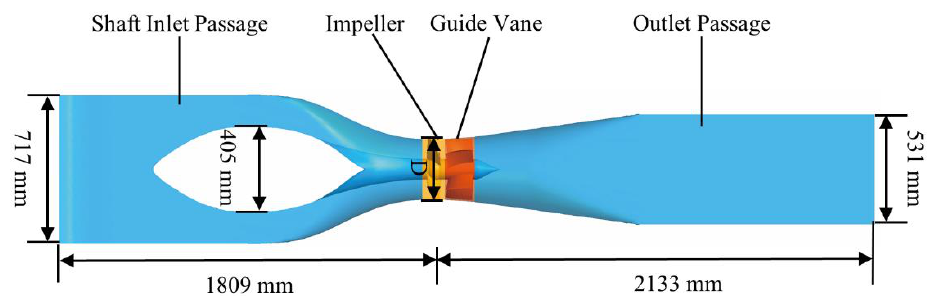
Figure 1. Three-dimensional model.